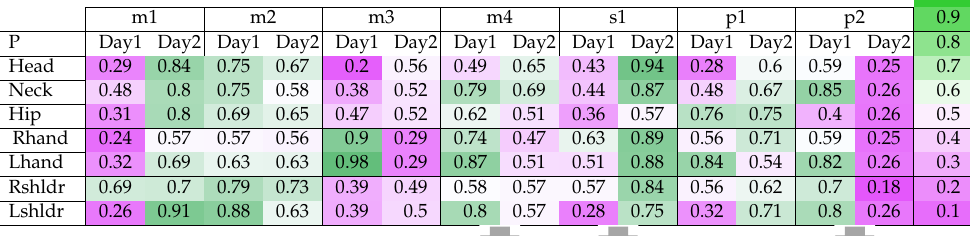
Table 1. Linear regression probability of each targeted joint motion per scene with MMSE score.